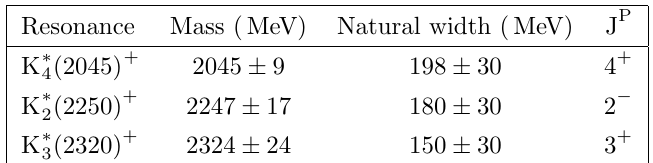
Table 1 . The mass, width, and J P quantum numbers for the known K (cid:3) + states [3] that can decay to (cid:3)p.